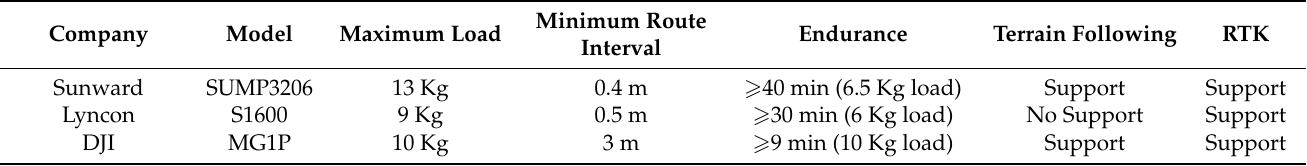
Table 2. Comparison of the UAV parameters.